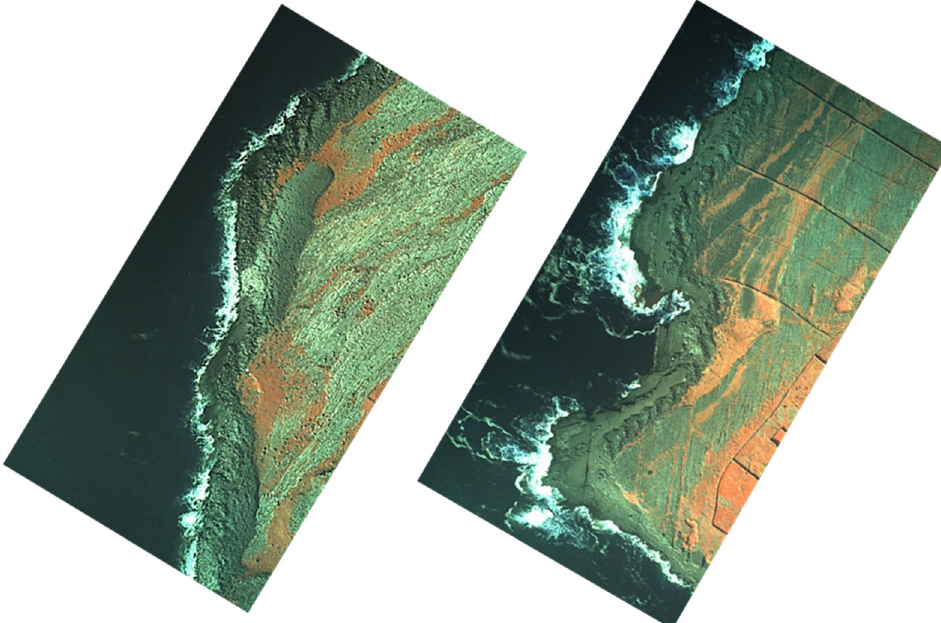
Figure 14. Left: 130 m long overwash boulder tongue 22 km inside Galway Bay, dated to about 5000 cal BP, with sharp outer contours, pushed ashore almost instantaneously during a lower sea level from a (littoral to sublittoral) deposit of well-rounded cobbles and small boulders (total mass about 10,000 tons). Right: 500 m long section of rhythmic crossway ripple ridges (height of 2–3 m) decorating the main boulder belt on a cliff top platform at +10 m mhw from the southern entrance to Galway Bay at Doolin Point northwards.